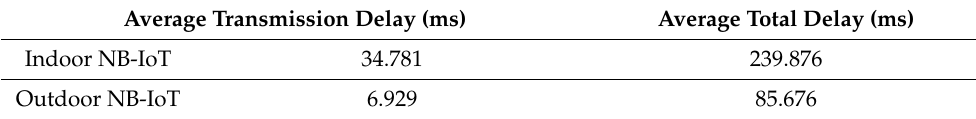
Table 2. Latency value for Critical Infrastructure in a Smart City as a